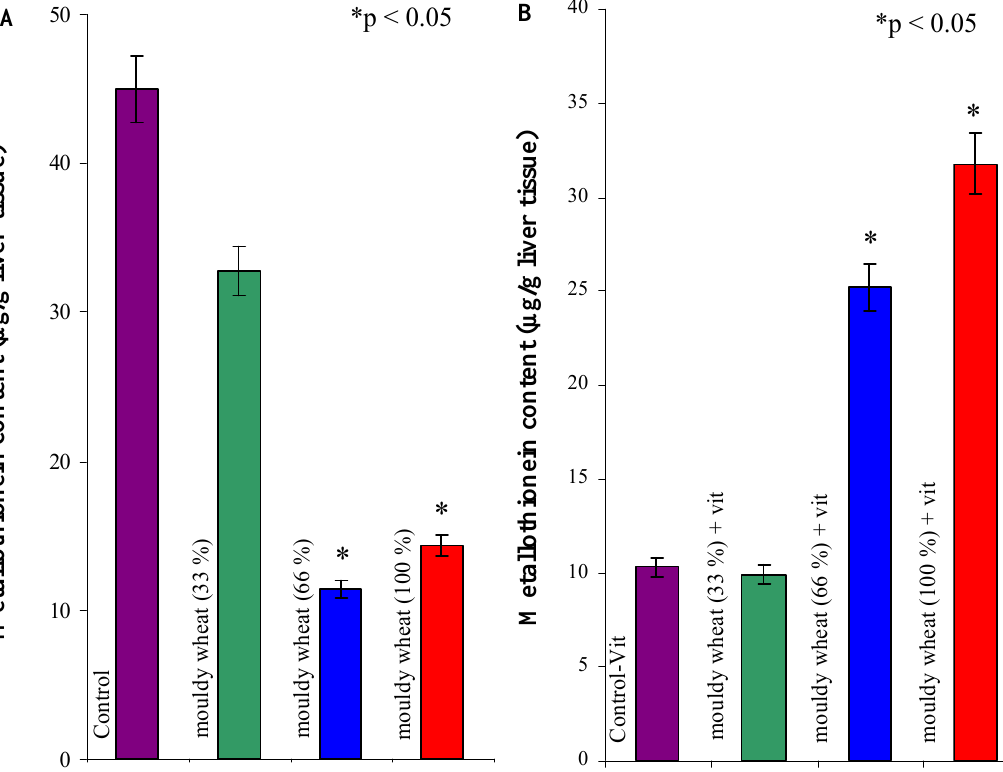
Figure 8. Changes of metallothionein levels in (A) rats exposed to mouldy wheat, (B) rats exposed to mouldy wheat and over-supplemented by vitamins at the end of the experiments (4 weeks); number of measurements = 5. Seven male rats per a group. Results were statistically treated by using of ANOVA, Scheffeho test. Differences with p < 0.05 were considered significant (vs. control